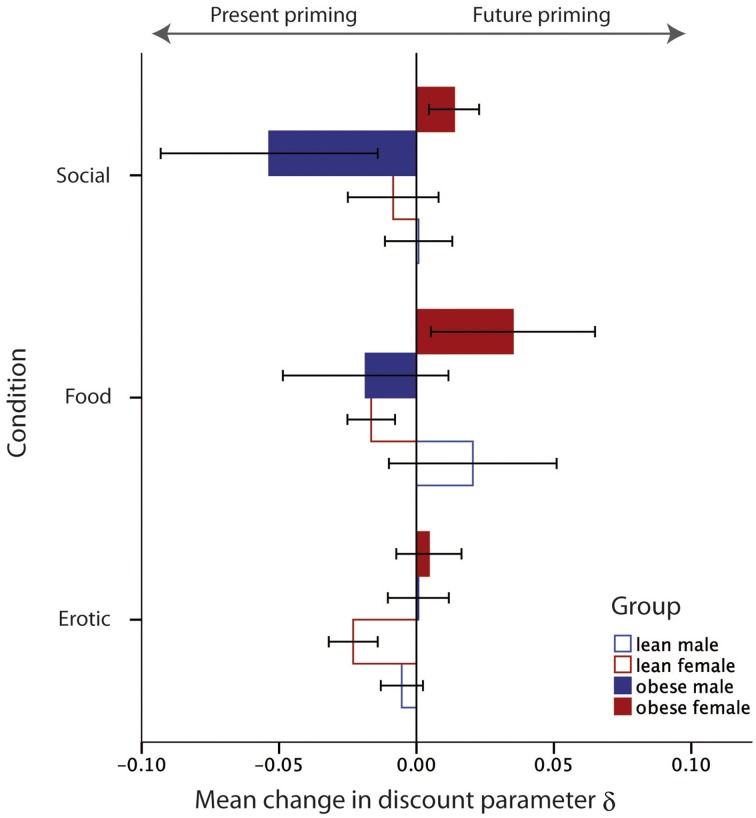
Illustration of the interaction between gender and weight status on the priming effect for the different priming categories. Values below zero indicate priming toward more present choices, values above zero indicate priming toward more future choices. Error bars indicate the standard errors of means (SEM).